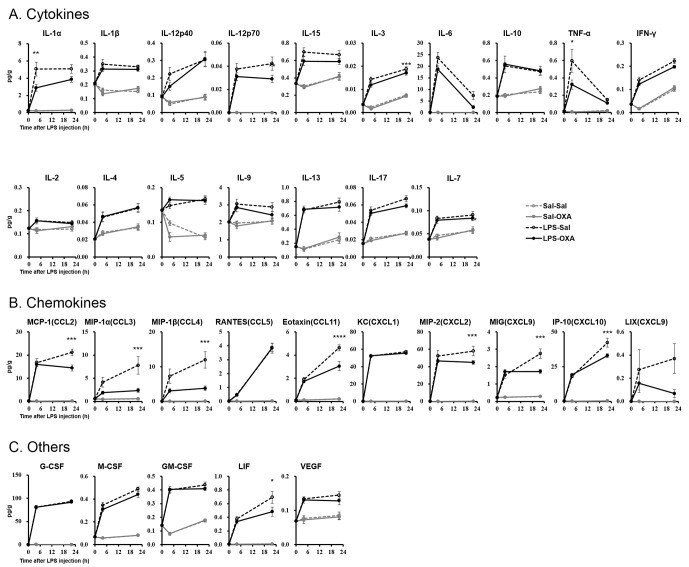
Effects of SC-infused OXA on cytokine production in brain at 4 hr or at 22 hr after LPS injection.LPS increased most cytokines in all samples assayed. SC administration of OXA (1 mg/mouse/24 hr, LPS-OXA) for 4 hr or 22 hr decreased several cytokine levels in the brain from LPS-injected mice, compared to saline SC administration (LPS-Sal) (each group n = 8, *p<0.05, **p<0.01, ***p<0.001).